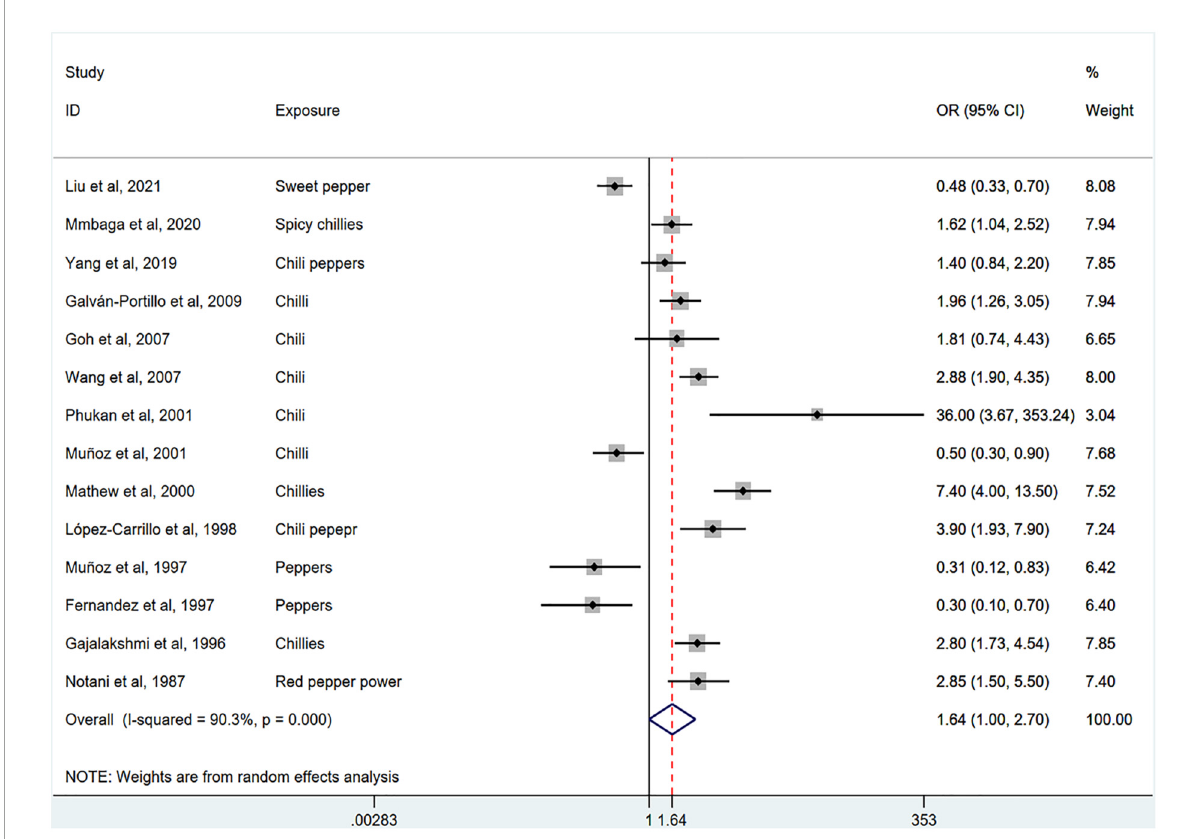
FIGURE2 Pooled analysis showing associations between chili pepper consumption and the risk of GI